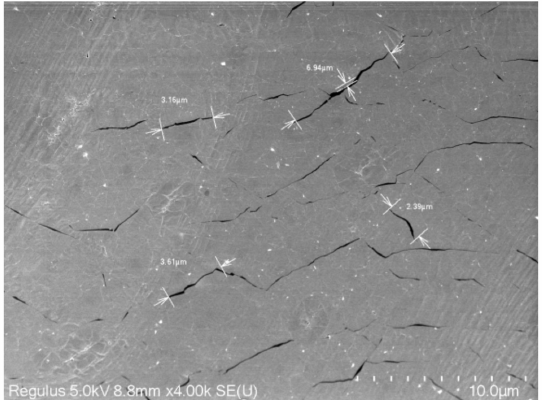
Figure 7. SEM figure of S3 after the cryogenic test. Many micro-scale rips can be